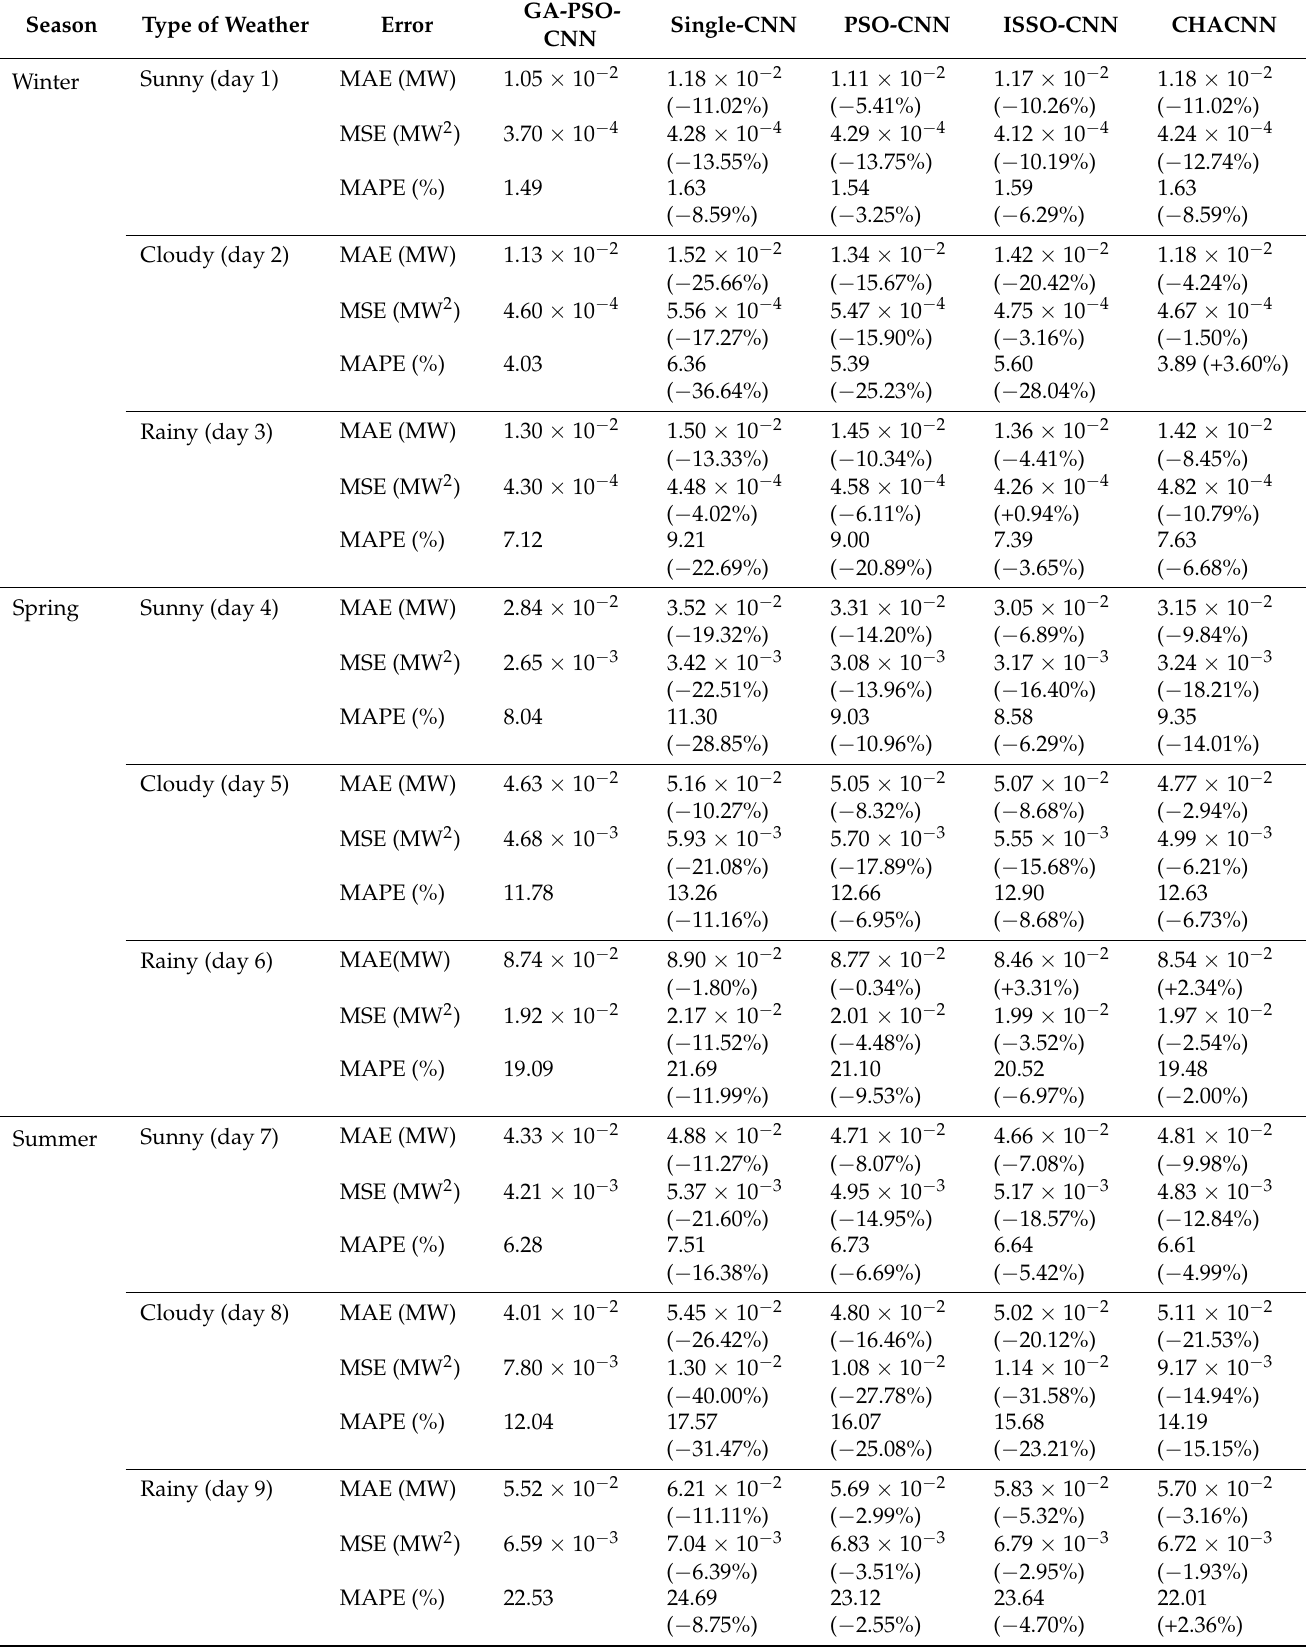
Table 5. Wind power prediction errors of each model on a certain